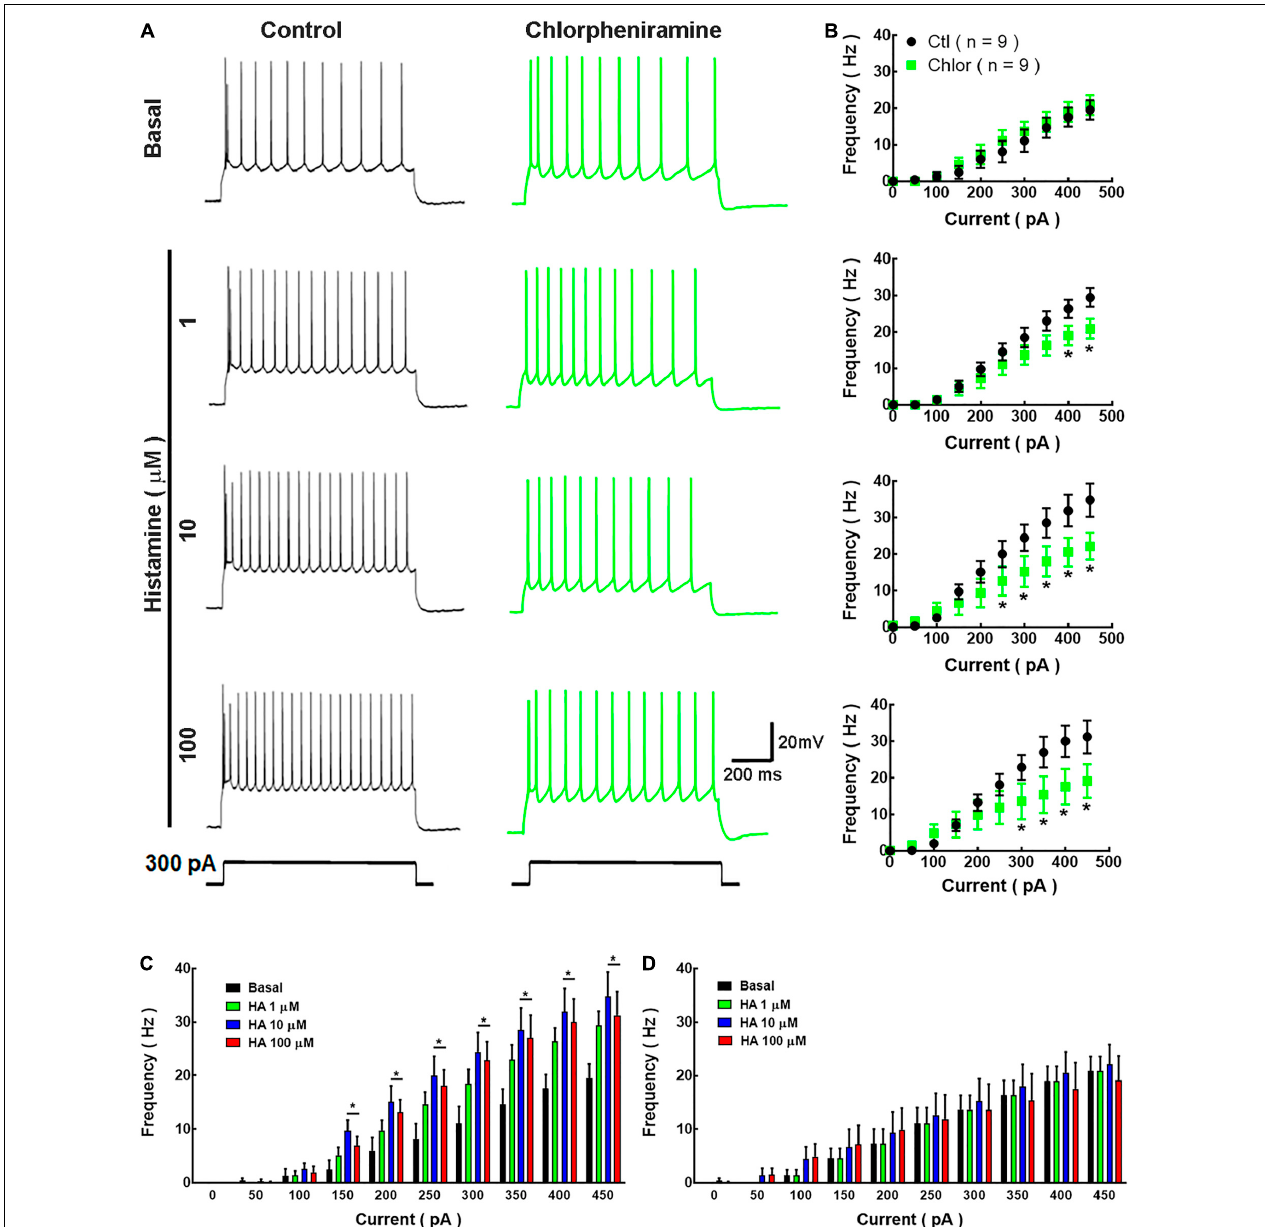
FIGURE 5 | Analysis of action potential frequency in deep cortical neurons. (A) Representative traces of the action potentials generated by a depolarizing pulse (300 pA, 1 s) in the absence and presence of histamine (1, 10, and 100 µ M) in deep cortical neurons of the offspring of Control (Ctl; black) and chlorpheniramine (Chlor; green) groups. (B) Current-frequency relationship. Values indicate the action potential frequency (Hz) induced by depolarizing currents (0–450 pA) and are means ± SEM from three independent experiments. * P < 0.05 when compared with the control group, Repeated Measures ANOVA and Sidak’s test. (C,D) Histamine effect on the current-frequency relationship in deep cortical neurons from the control and chlorpheniramine groups, respectively. Values are means ± SEM from nine neurons for each condition from 6 P21 animals from three different litters per group. * P < 0.05 compared with the corresponding basal value; one-way ANOVA and Dunnett’s multiple comparisons